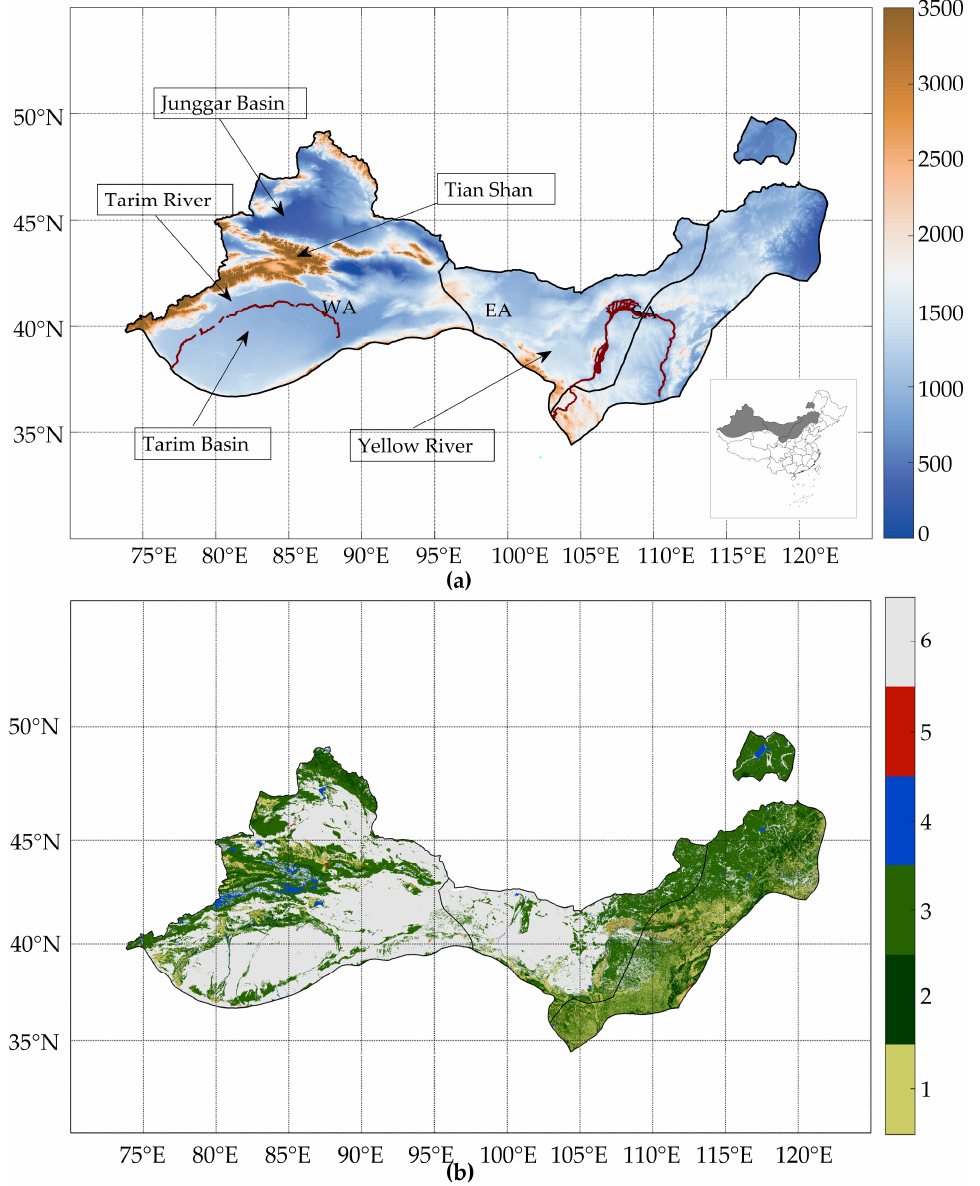
Figure 1. The location of drylands of China. ( a ) Topography. The DEM (Digital Elevation Model) of GTOP30 data is used; ( b ) Land use cover. They are: (1) cropland, (2) woodland, (3) grassland, (4) water body, (5) build-up area and (6) unused land.